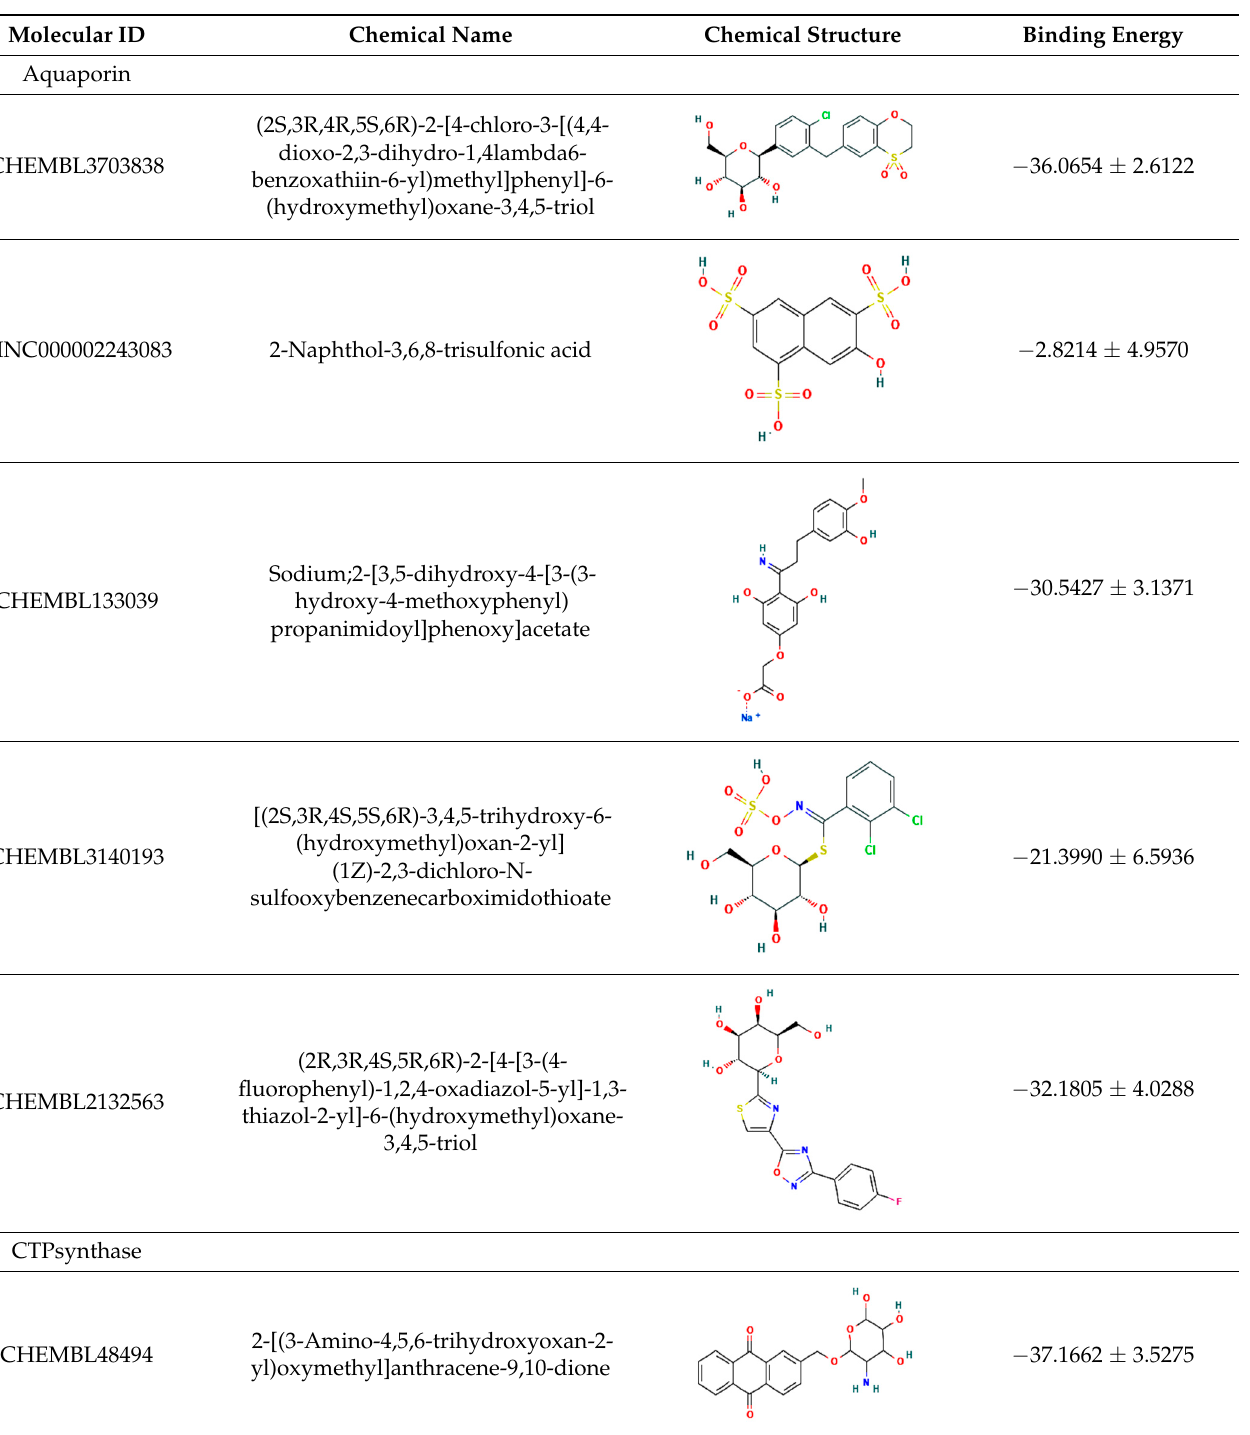
Table 4. The two-dimensional structures and binding energies of the best five compounds selected against the target proteins.